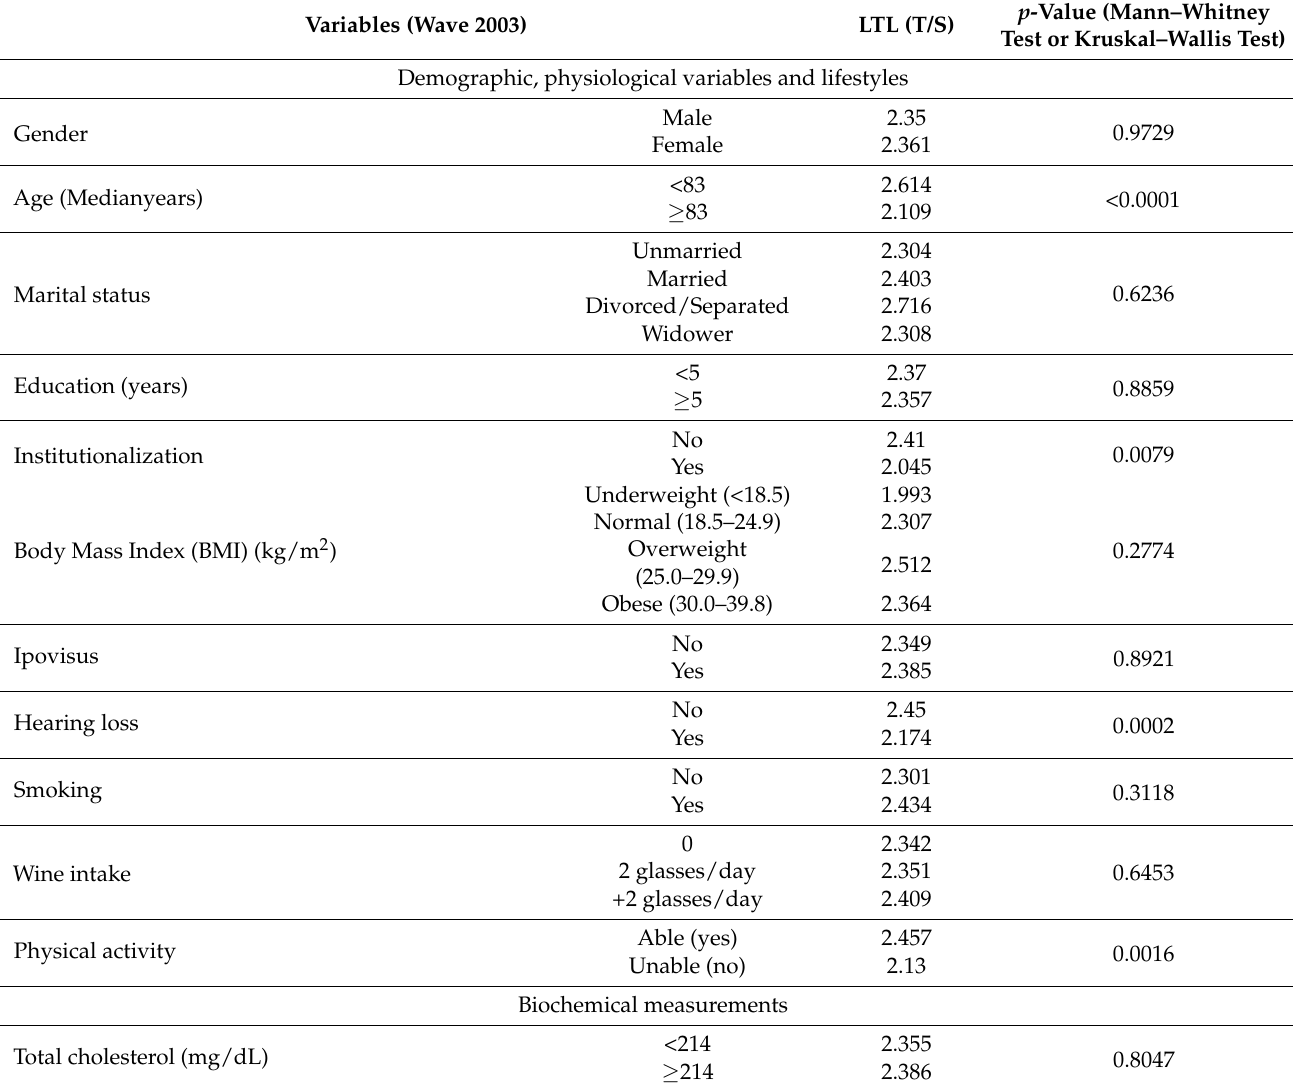
p -Value (Mann–Whitney Test or Kruskal–Wallis Test)